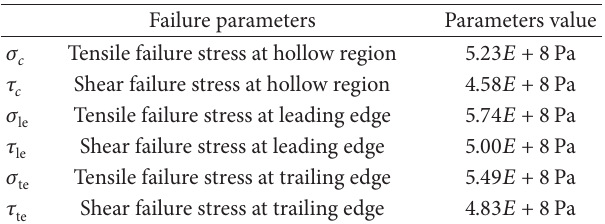
Table 5: The bond strength parameters.